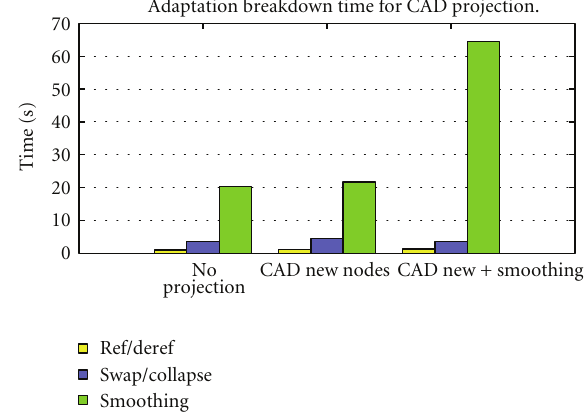
Figure 30: Adaptation blocks times for CAD projection after 1 adaptation step with 16 processors. ONERA M6 wing.